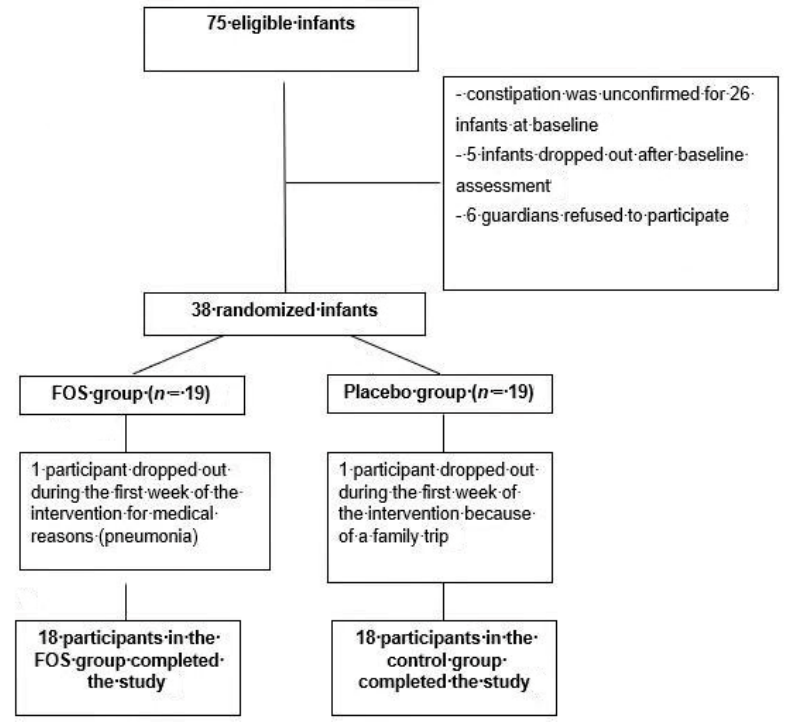
Figure 1. Flowchart showing the study participants. FOS: fructooligosaccharide.